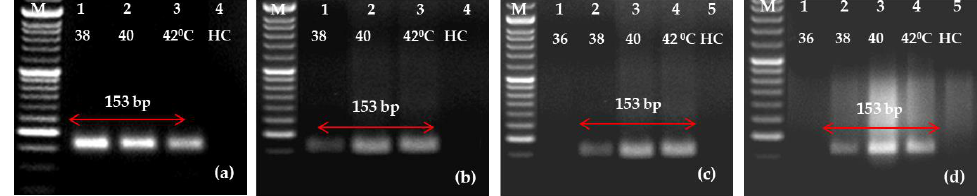
Figure 4. Optimization of one-step reverse transcription-recombinase polymerase amplification (RT-RPA) for potato leafroll virus (PLRV) detection using primer pair C (LRRPAF3/R3) at different temperature regimes (38, 40 and 42 °C). The gel-electrophoresis generated images depict the RT-RPA amplified amplicons in a heating block ( a , c ) and in a water bath ( b , d ). The purified RNA as the template was used in RT-RPA in ( a , b ); whereas the simple RNA has been used for ( c , d ). Within each gel documentation image, three lanes (1, 2 and 3) depict the PLRV-infected samples along with a 50 bp ladder (Lane M). Lane 5 ( c , d ) denotes the healthy control.